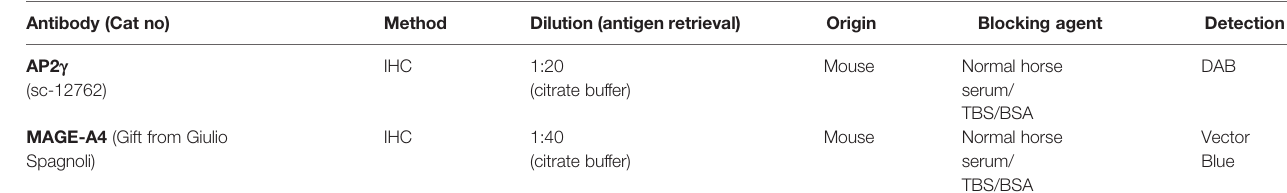
TABLE 1 | Summary of immunohistochemistry